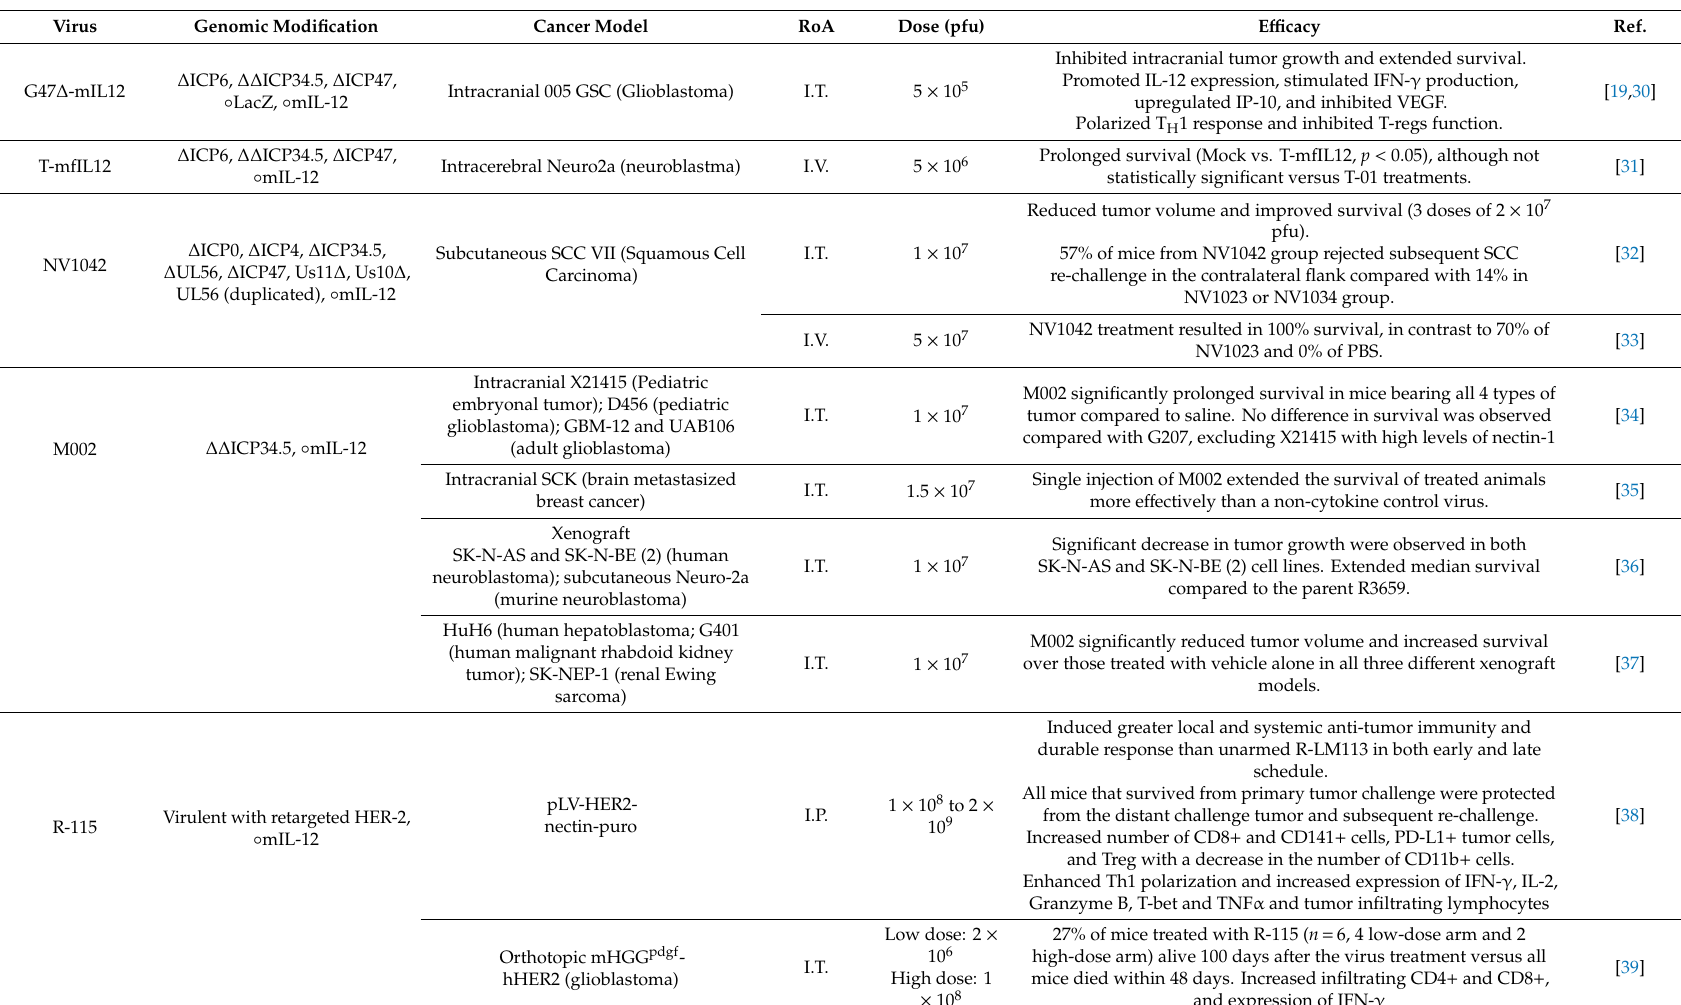
Table 1. List of OHSV-IL12s and their e ffi cacy in pre-clinical cancer